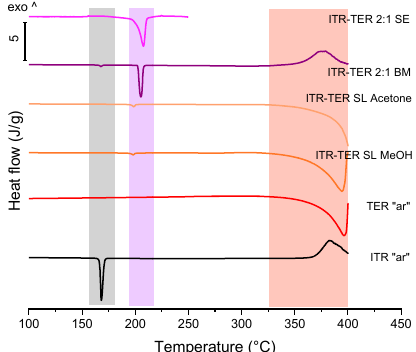
2:1 ball milled system (Figure 5) verified that ball milling was more e ffi cient in producing the cocrystal, with a sharp melting peak with a normalized enthalpy of 83.7 J / g. Pharmaceutics 2020 , 12 , x FOR PEER REVIEW